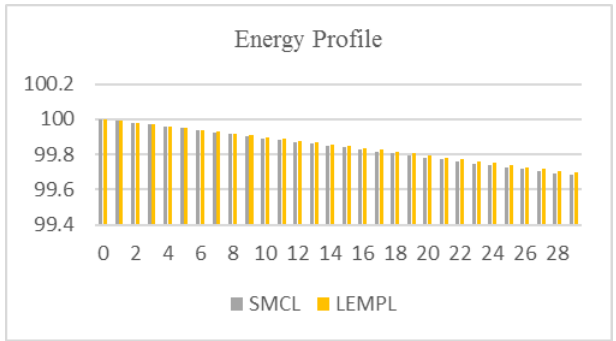
Figure 7. Energy Profile of Sensor Nodes after 150 Sec of Simulation